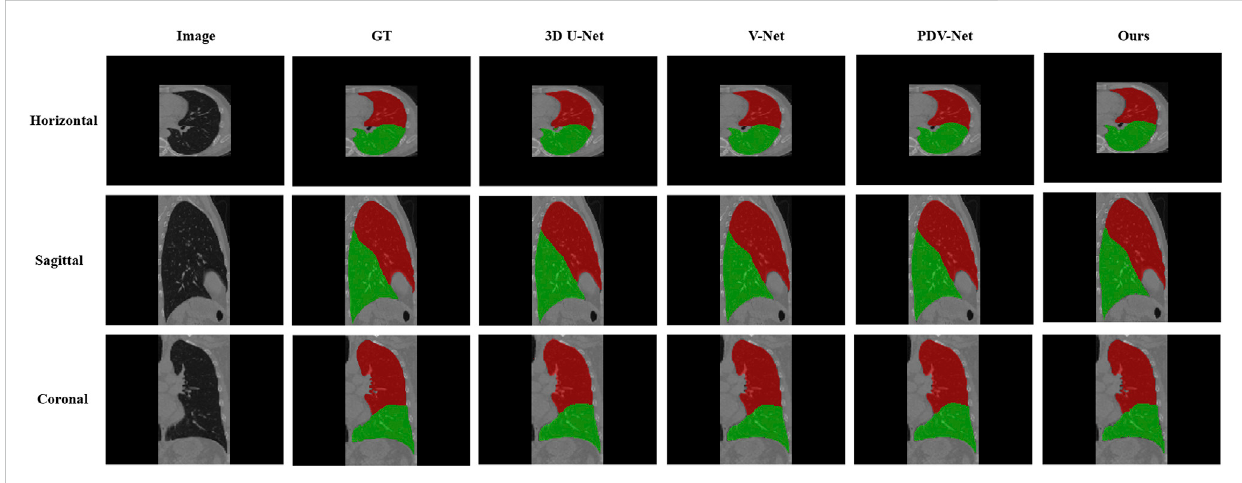
FIGURE 5 Visual comparison between our proposed model and 3DU-Net, V-Net, PDV-Net and ground truth; This fi gure shows the segmentation results of cross section, sagittal plane and coronal plane of the left lung region; Color indicates that red: Left Upper Lobe; Green: Left Lower Lobe.